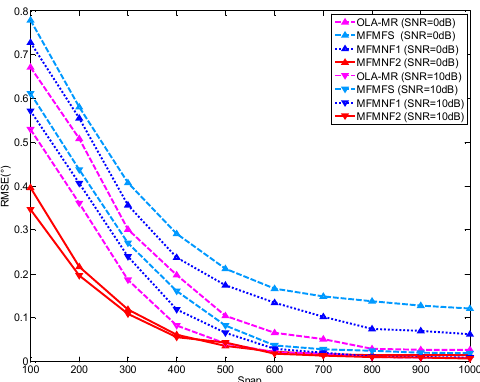
Figure 5. RMSE under a varying number of snapshots for different SNR values.